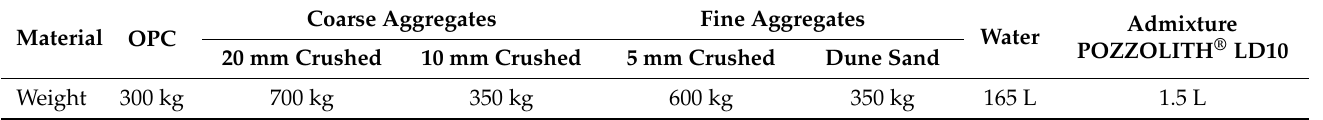
Table 2. Proportions of the concrete mix per cubic